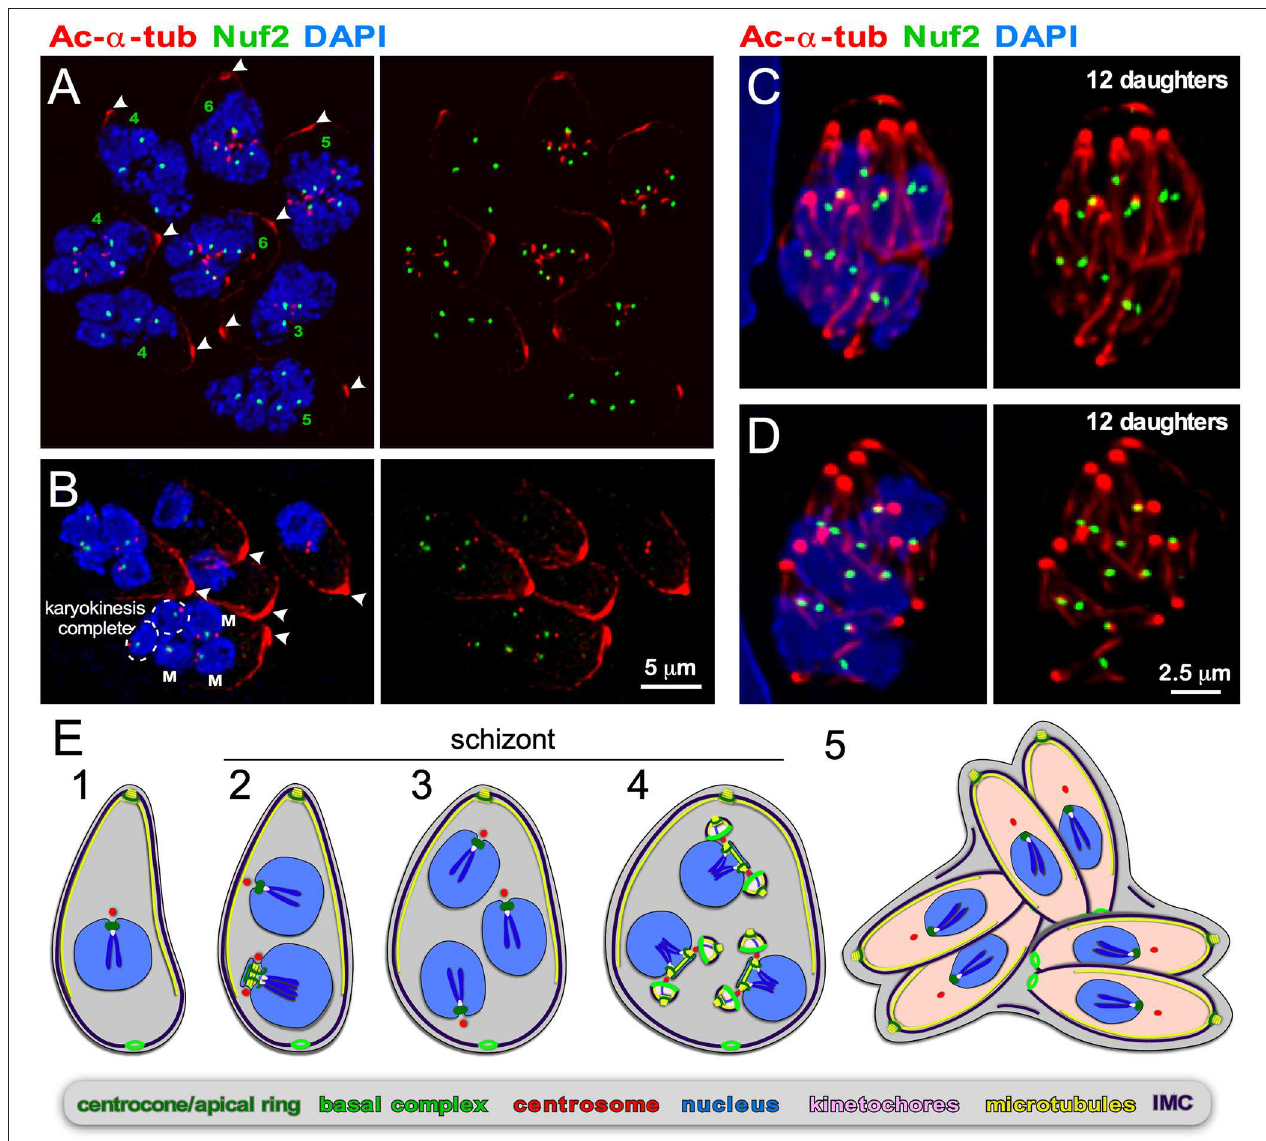
FIGURE 5 | Endopolygeny with karyokinesis during merogony of Cystoisospora suis . (A–D) Parasites at different stages of endopolygeny. Acetylated (Ac) α -tubulin (red) marks the mother cells conoid [arrow heads in (A,B) ], subpellicular microtubules, the spindle poles associated with nuclei undergoing mitosis, and the daughter conoids and subpellicular microtubules (C,D) . Antiserum generated against TgNuf2 (green) marks the clustered kinetochores at mitotic spindles. (A) Eight parasites at different stages in the division cycle. Green numbers indicate the number of spindle poles seen per mother cell, which is expanding non-geometrically in five of the parasites indicating asynchronous nuclear cycles. (B) Five parasites at different stages of endopolygeny are shown. The parasite on the bottom has five nuclei: nuclei marked “M” are in early stages of mitosis as two spindle poles flanking a single 2N kinetochore cluster are seen; the circled nuclei represent just completed mitosis as the kinetochore clusters are relatively weak intensity (1N vs. 2N) and associated with only a single spindle pole. (C,D) Two examples of cells at the synchronous daughter budding stage, which both produce 12 daughters as enumbered by the number of kinetochore clusters, again, consistent with non-geometric expansion of the nuclei. (E) Schematic of apicomplexan asexual cell division by endopolygeny with karyokinesis. Note that the mitotic cycles of the nuclei in the same cytoplasm are not synchronous (2) resulting in non-geometrically expanded daughter numbers (4,5). Also note that the mother’s cytoskeleton is maintained throughout the meront (technically “schizont”) stages and is only destabilized just before emergence of nearly mature daughters (5).